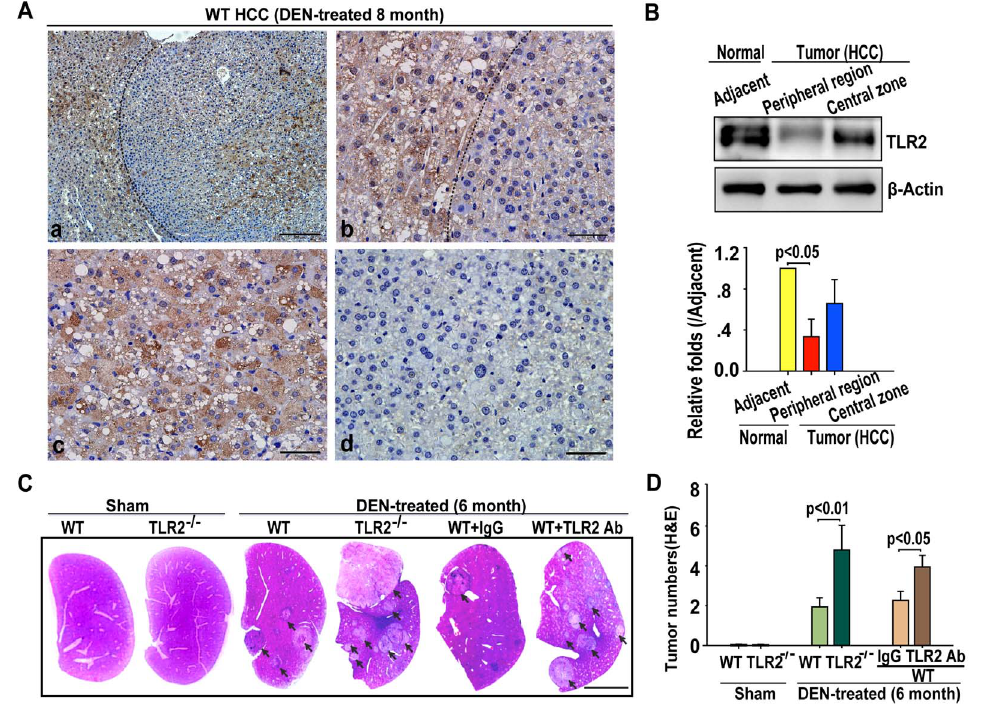
Figure 1. TLR2 deficiency promotes DEN-induced HCC in mice. (A) Representative images of TLR2 immunostaining in liver tissue from WT mice at 8 months post-DEN injection (n=4 per group). (a) Histological image of HCC with an anti-TLR2 antibody. Scale bars, 200 m m. (b) Histological image of HCC with an anti-TLR2 antibody to show normal tissue adjacent HCC and peripheral region of HCC. Scale bars, 50 m m. (c) Histological image of HCC with an anti-TLR2 antibody to show central zone of HCC. Scale bars, 50 m m. (d) Histological image of negative control with an anti-IgG antibody. Scale bars, 50 m m. (B) Expression of TLR2 was detected in normal tissue adjacent HCC, peripheral region and central zone of HCC. Data are presented immune blots (top panel) and mean 6 SEM (n=4 per group, bottom panel). (C) Representative H&E images of liver sections from the WT, TLR2 2 / 2 , IgG-treated WT, or WT mice treated with anti-TLR2 at the six-month after DEN treatment. Scale bars, 1 cm. (D) Blocking TLR2 activity, either by TLR2 knockout or by anti-TLR2 antibody, enhanced the numbers of DEN-induced tumor nodules detected by H&E staining (n=15 per group).